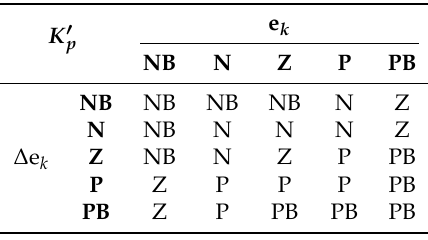
Table 2. Fuzzy tuning rules for K (cid:48)